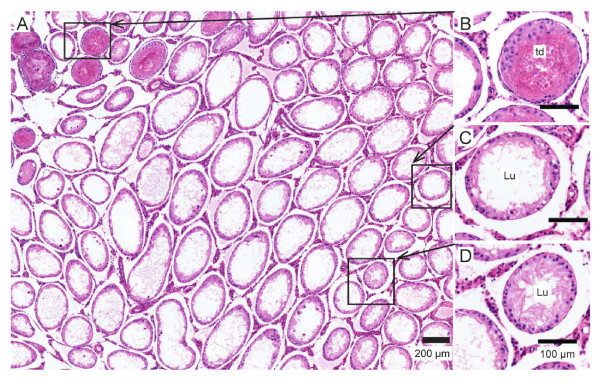
Testis histology two weeks after 3 MHz ultrasound (Group 4). (A) The loss of spermatogenic cells after this treatment was more complete than after the wet heat treatment. This resulted in a shorter epithelium and a larger diameter lumen. (B) An isolated cluster of tubules in this particular animal showed evidence of thermal damage (td) in addition to the loss of spermatogenic cells. (C) Most tubules had a very short epithelial layer and increased lumen diameter due to the loss of all spermatocytes and spermatids. (D) Tubules that appear to have a larger epithelial layer and smaller diameter lumen were still missing spermatocytes and spermatids.